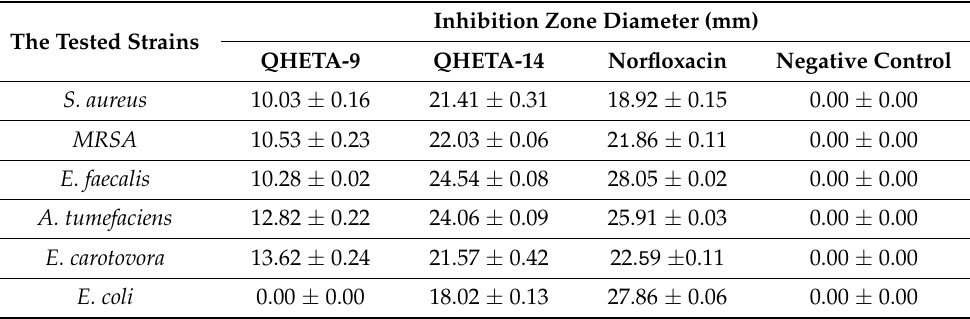
Table 2. ScreeningofantibacterialactivityofQHETA-9andQHETA-14againstthetestedbacterialpathogens.